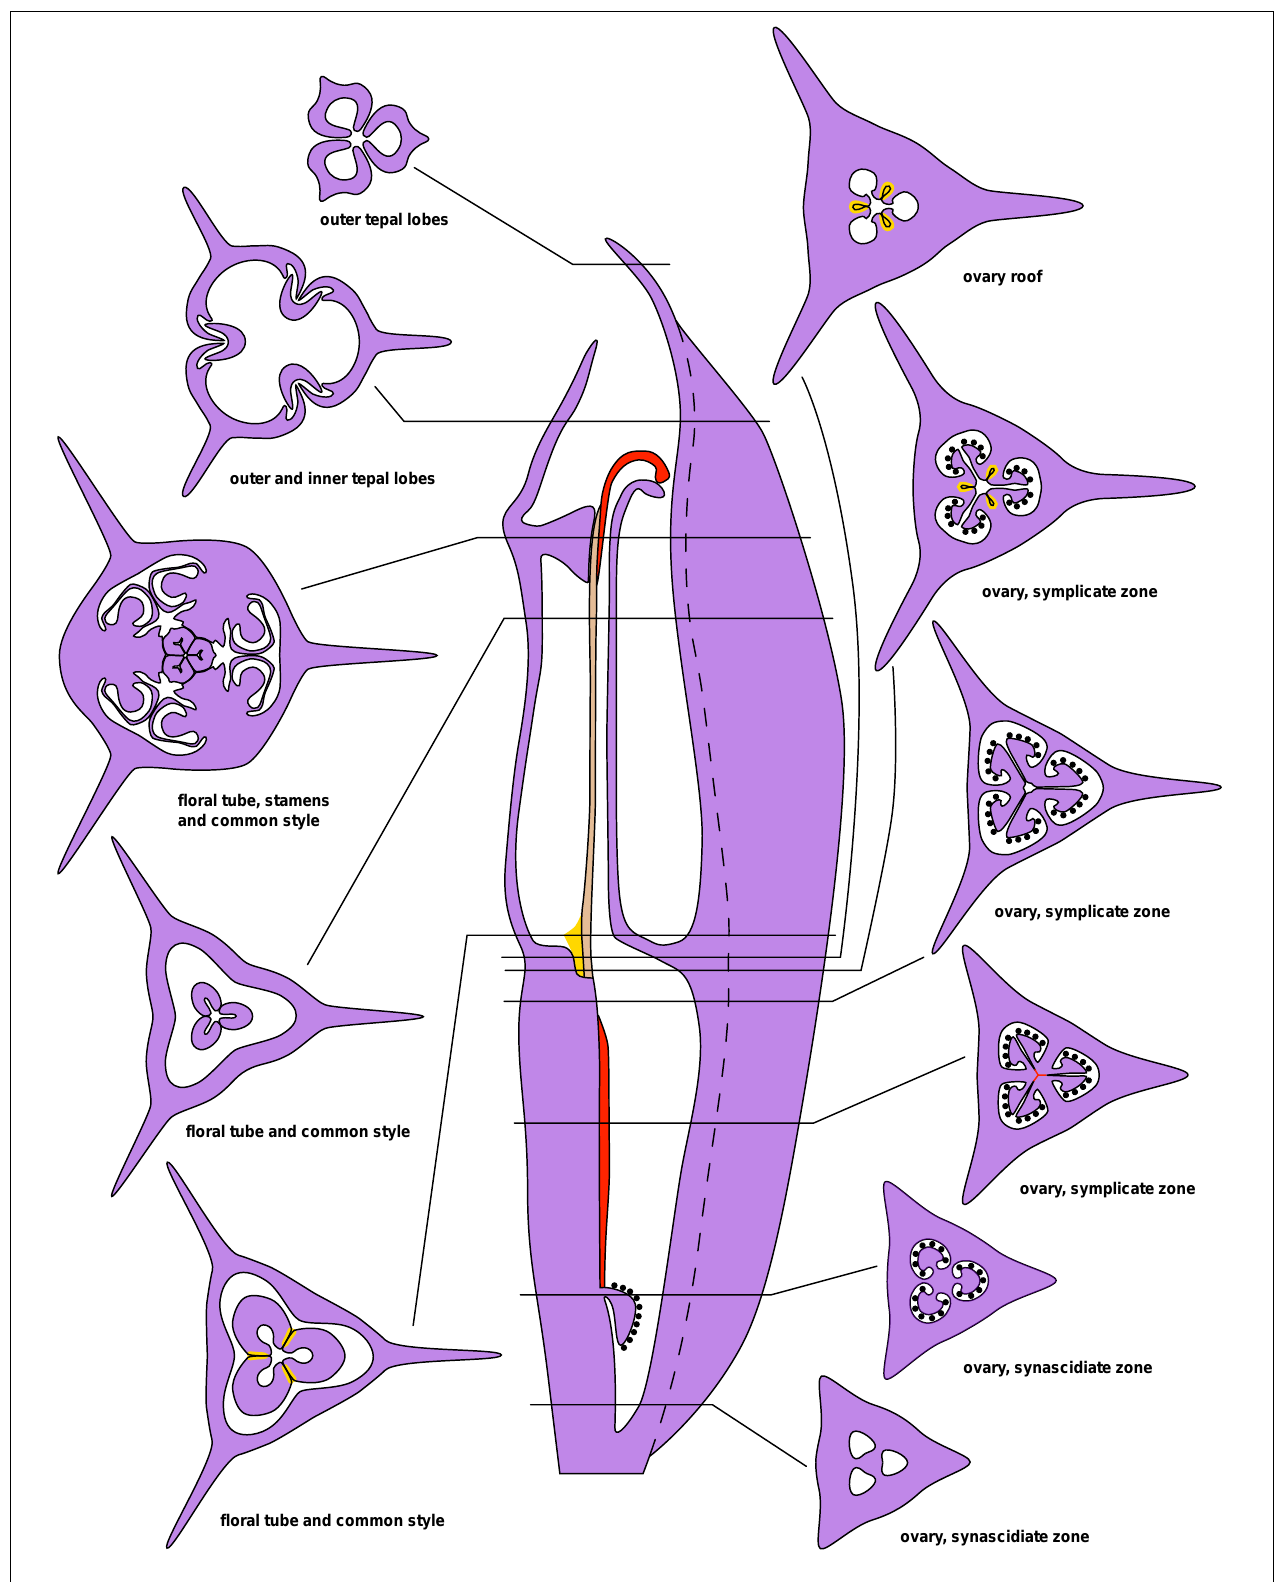
FIGURE 2 | Diagrams of longitudinal section and transverse sections of a flower of Burmannia exemplified by B. disticha . Dashed lines indicate boundary of perianth wing; red areas and lines: postgenital fusion within carpels; brown area: postgenital fusion between carpels; yellow areas: septal nectaries.